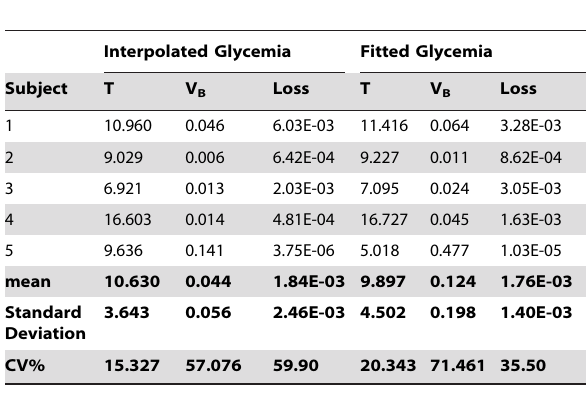
Table 4. Parameter estimates for the RTH model, Slope fixed to 1.